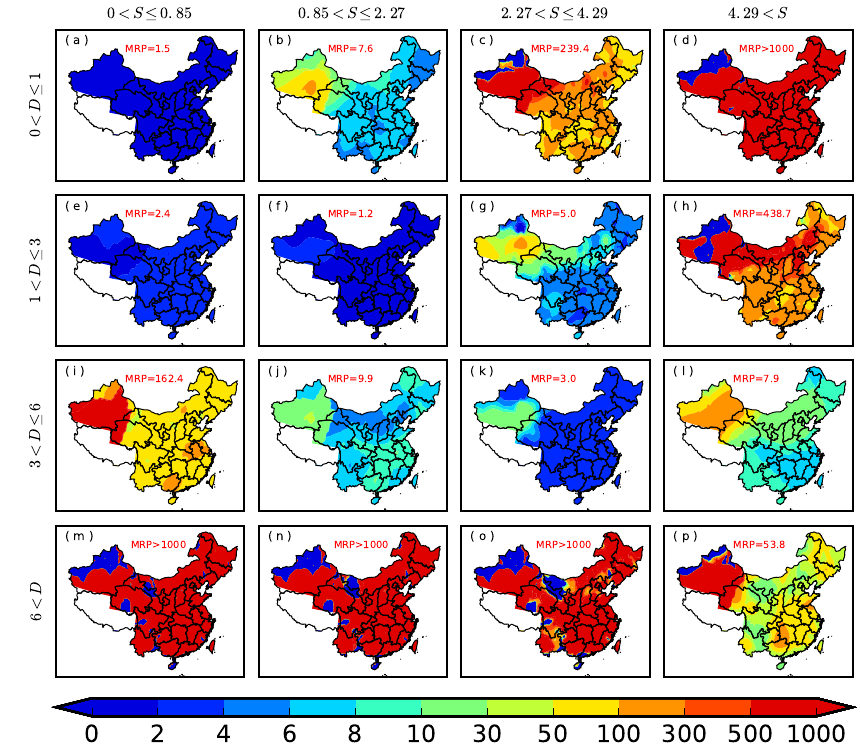
Figure 14. Return period based on entropy method (the unit of the colored bar is years). ( a – p ) represent the different drought